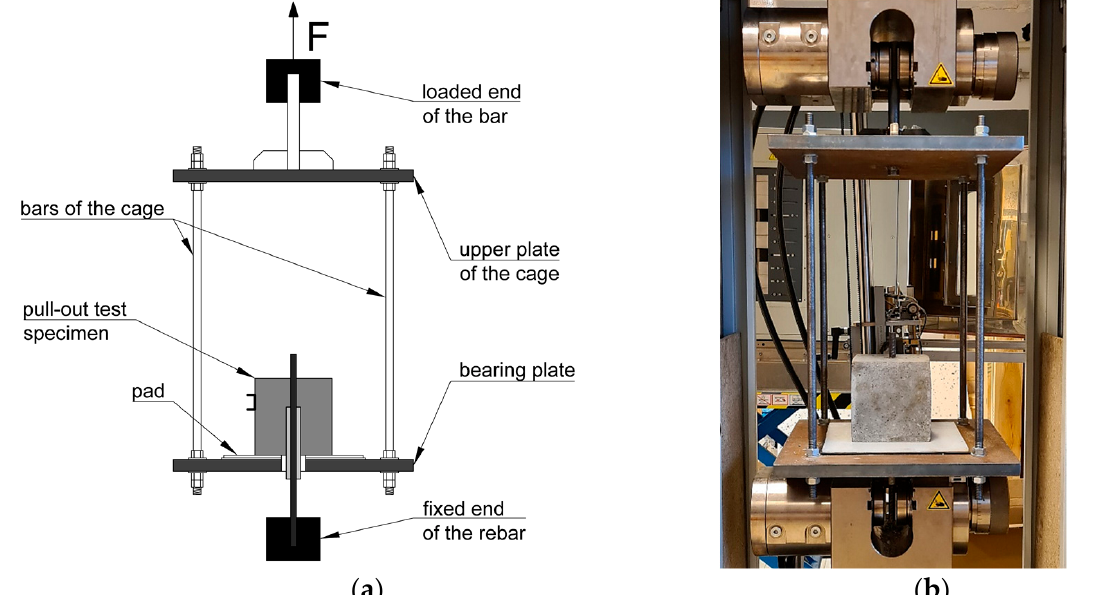
Figure 5. Test stand for the pull-out test: ( a ) Schematic view with details; ( b ) Actual view.